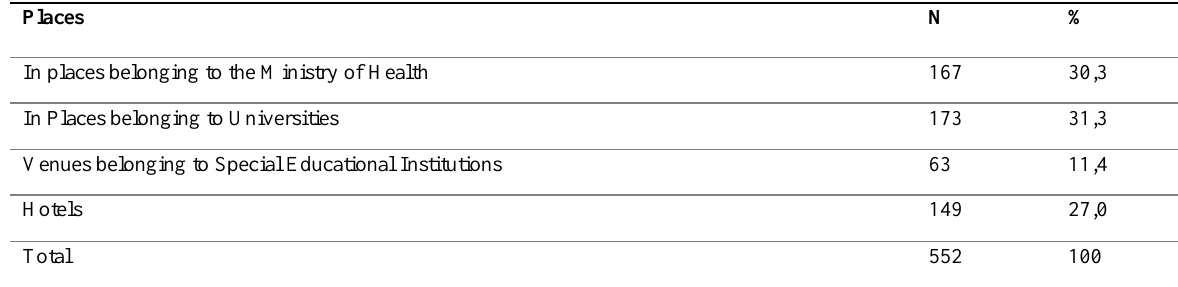
Table 19: Venues to Organize In-Service Trainings